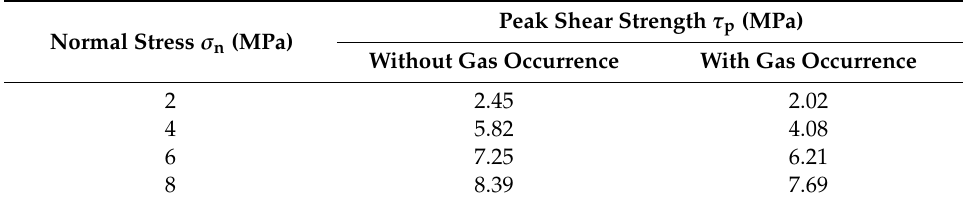
Table 2. Peak shear strength of grouted rock